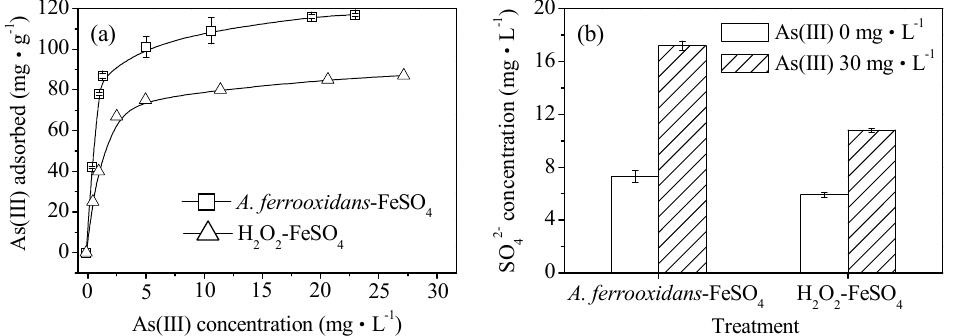
Figure 4. ( a ) As(III) adsorption capacity and ( b ) SO 42 − variation during As(III) adsorption on biologically and chemically synthesized schwertmannite at 28 °C and 180 rpm for 4 h. Experimental conditions: initial pH = 7.5; As(III) concentration 0–40 mg·L −1 ; schwertmannite 0.25 g·L −1 .